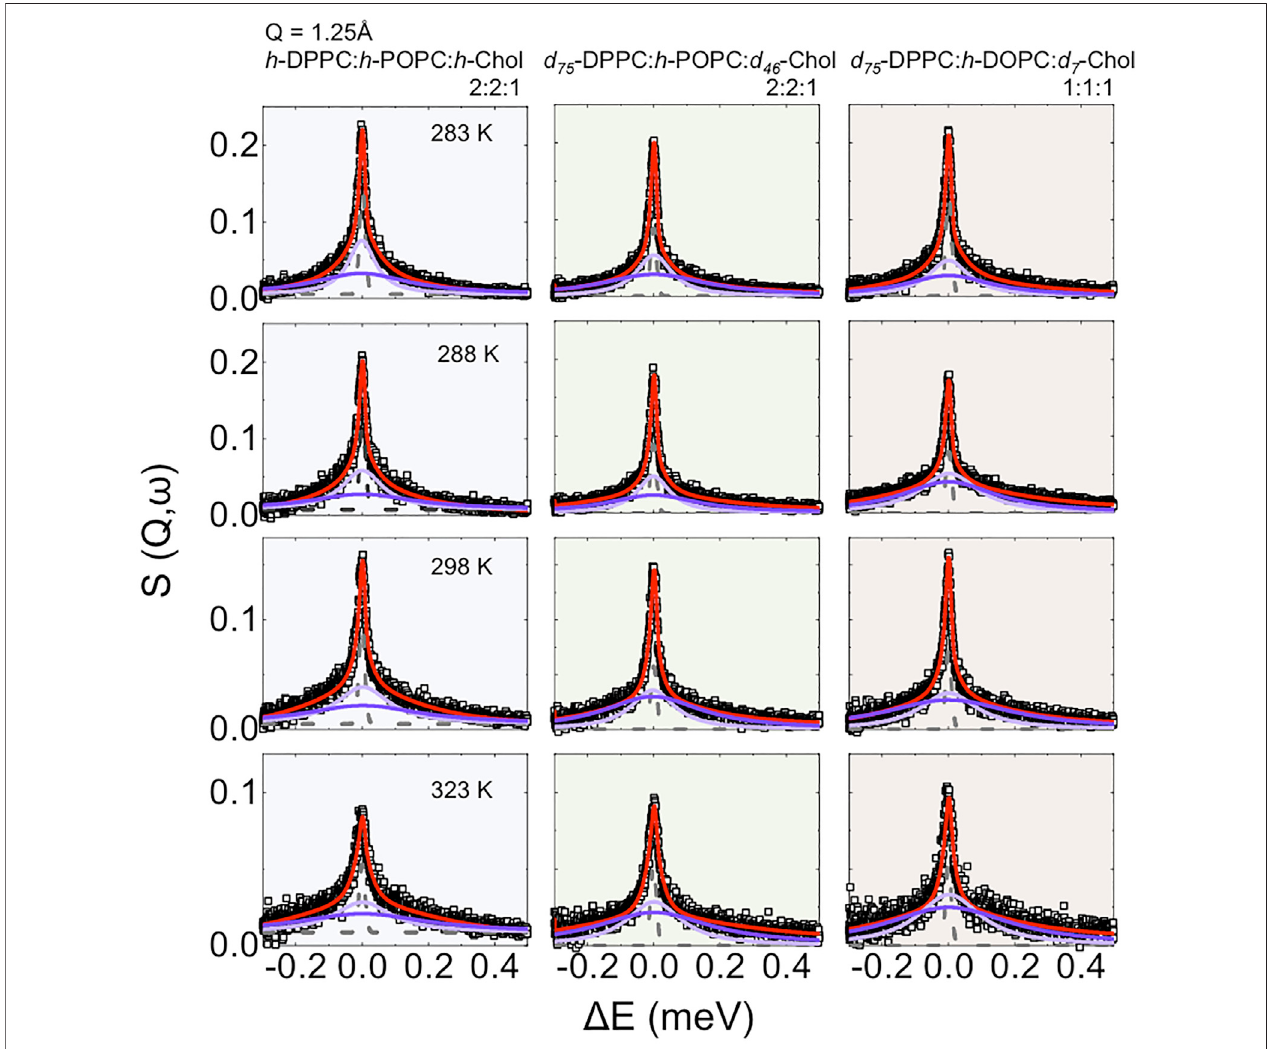
FIGURE4 | QENS S (Q, ω ) data and model fi tat arepresentative value of Q = 1.25 Å -1 , measured onIRIS, with 17.5 μ eV resolution, between 283and 323 Kfor: 1) h -DPPC: h -POPC: h -Chol molar ratio 2:2:1 (in this contrast the dynamics of all three components contributes to the scattering pro fi le); 2) d 75 -DPPC: h -POPC: d 46 -Chol molarratio2:2:1(in thiscontrastmostofthesignalisduetoPOPC;theothercomponents arevirtually “ invisible ” ) and3) d 75 -DPPC: h -DOPC: d 7 -Cholmolarratio1:1:1(in this contrast most of the signal is due to DOPC; the other components are virtually “ invisible ” ). The central line (grey) due to elastic scattering is modeled by the instrumental resolution. The narrow Lorentzian signal (light purple) indicates the lipid diffusion; the broader (dark purple) component represents the lipid segmental relaxation. The global fi t (red continuous curve) is overlain on the data points (black open squares).